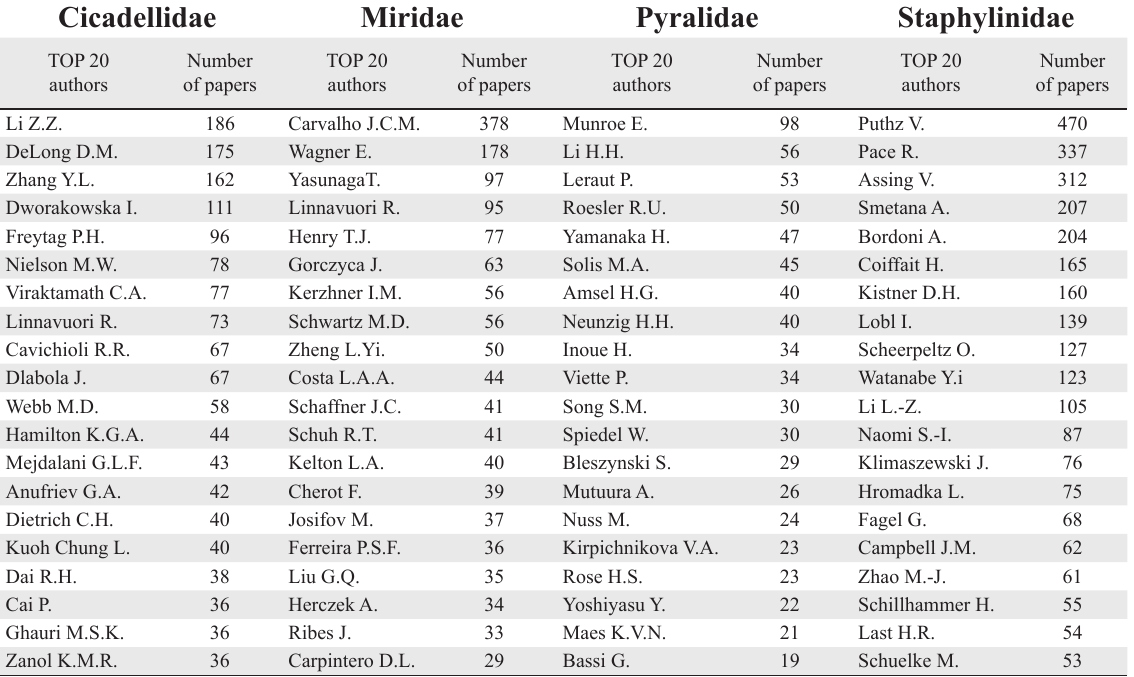
Table 1. Top 20 most productive authors for the four families (Cicadellidae, Miridae, Pyralidae